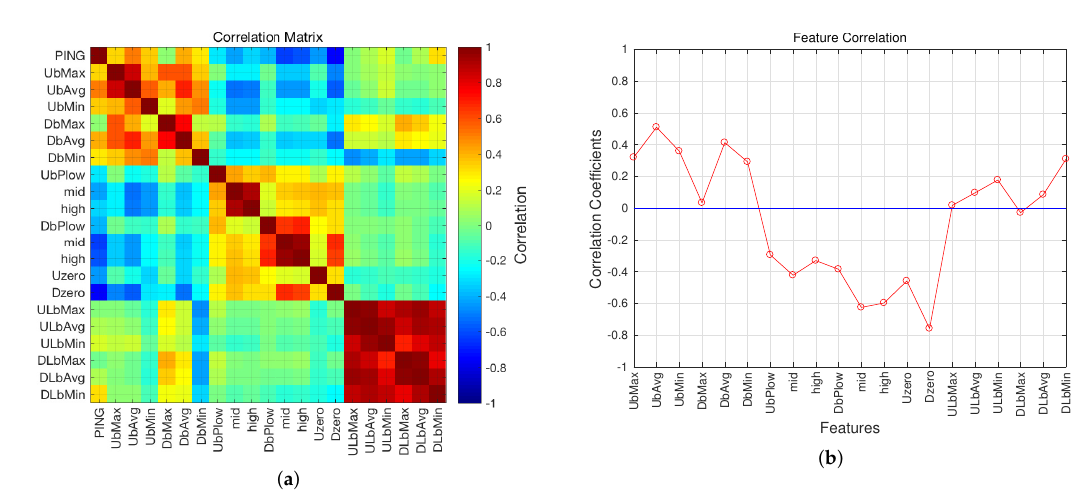
Figure 8. Correlations of the 20 features (F1-F20) extracted from the BPS signal and PSR (“PING”) of Daejeon TS. ( a ) Correlation matrix. ( b ) Correlations between the 20 features and PSR.